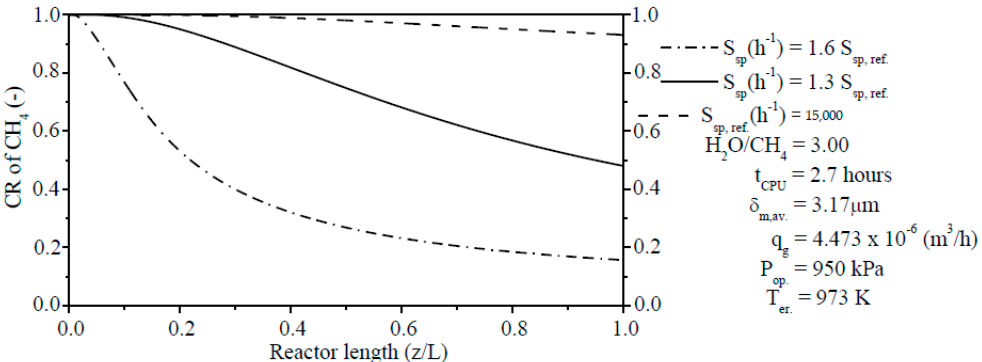
Figure 8. Effect of the S sp on the CR of CH 4 along the reaction zone length from PBMR on Ni/ γ -Al 2 O 3 .